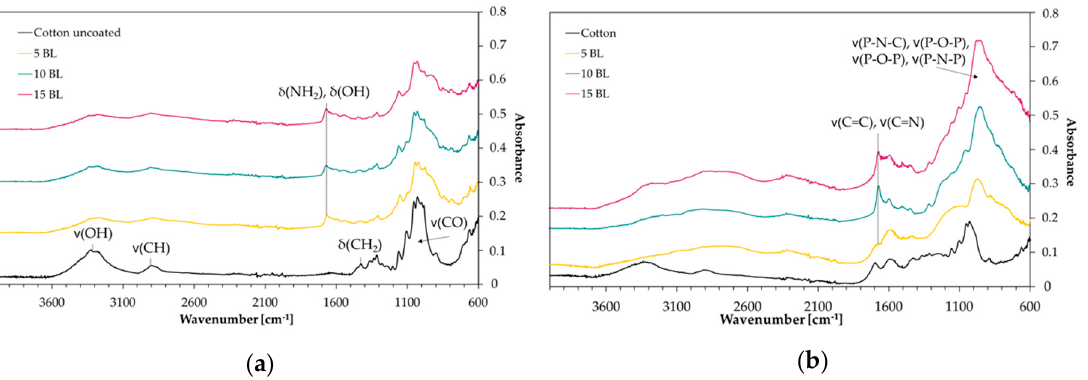
Figure 6. ATR-FTIR absorbance spectra. ( a ) Uncoated and coated cotton samples; ( b ) charred samples after flame test.